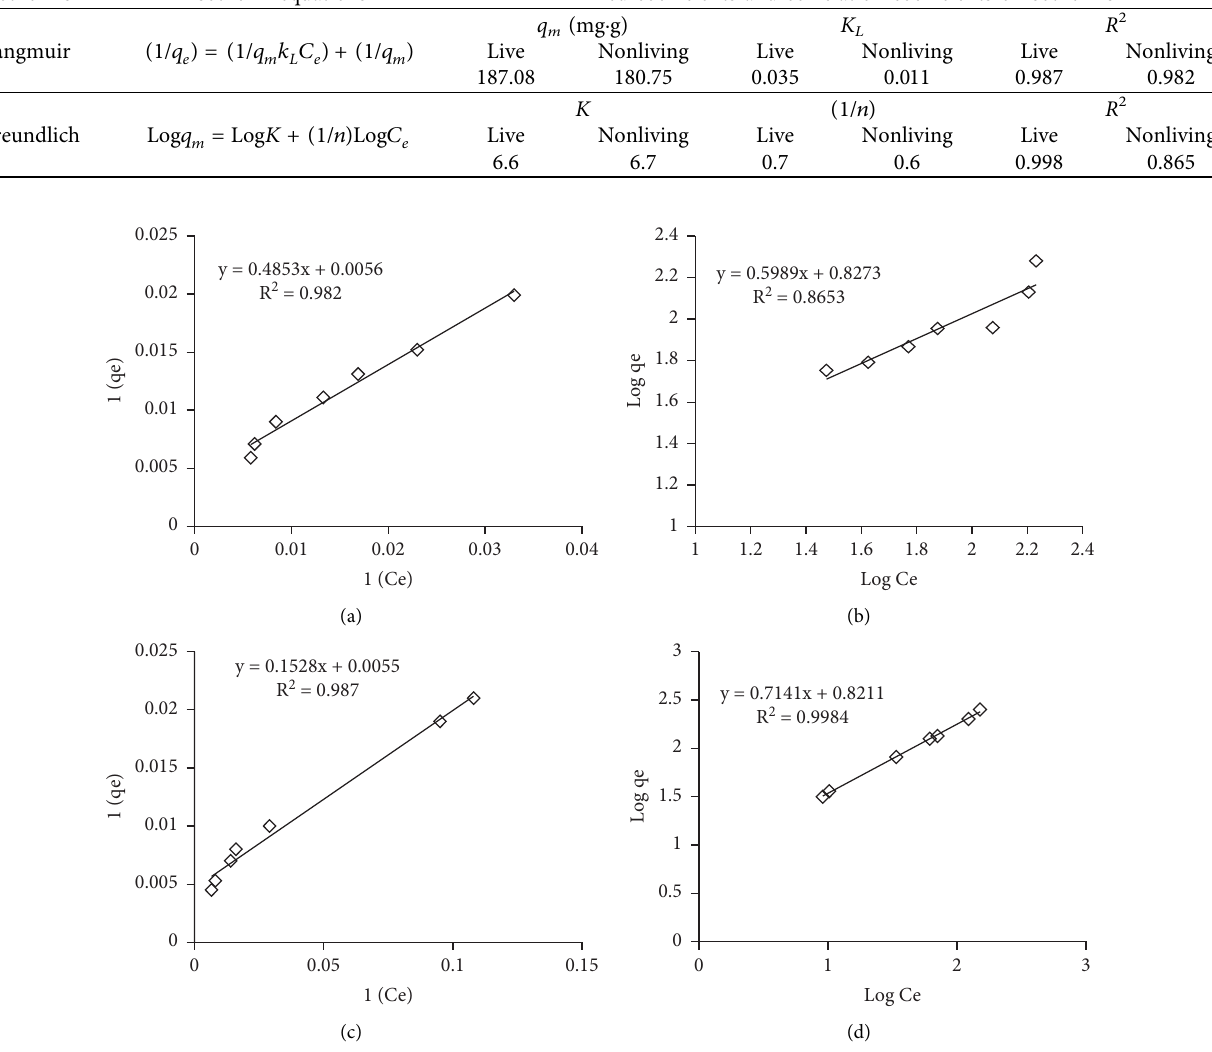
Table 1: Fixed and correlation coefcients of Langmuir and Freundlich isotherms (nonliving and living biomass). Isotherms Isotherm equations Fixed coefcients and correlation coefcients of isotherms